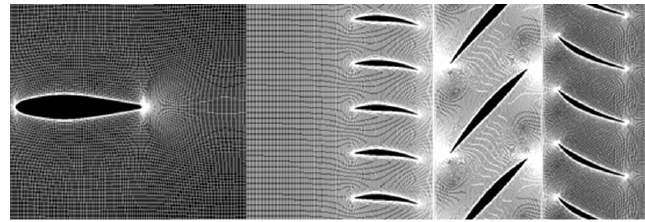
Figure 10. Fluid mesh at 50% blade span. The finite element mesh type of the R1 blade is Solid186, which is a 20 ‐ node hexahe ‐ dral element. The R1 blade has 40,230 mesh nodes. The mesh is shown in Figure 11.